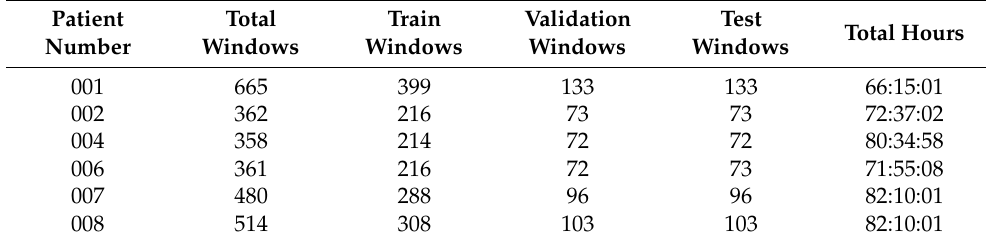
Table 4. Number of windows and total hours per patient.